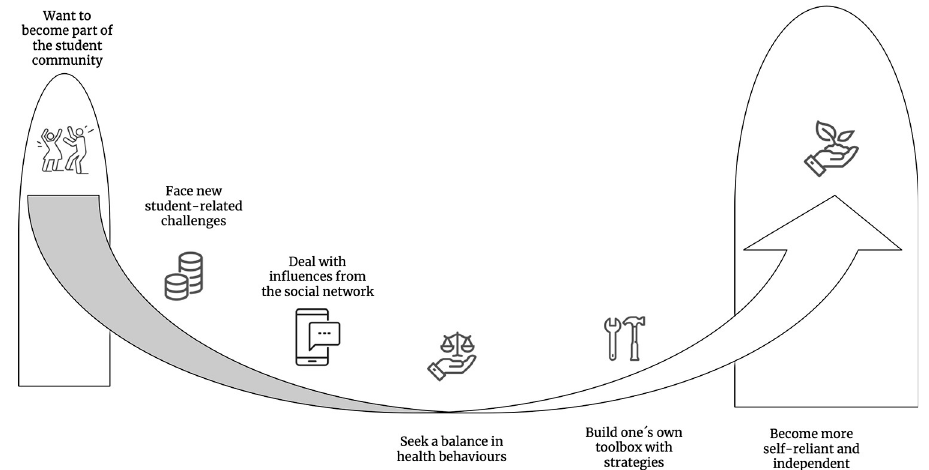
Fig 1. Illustration of the comprehensive understanding: Interview participants’ experiences of the balancing act.